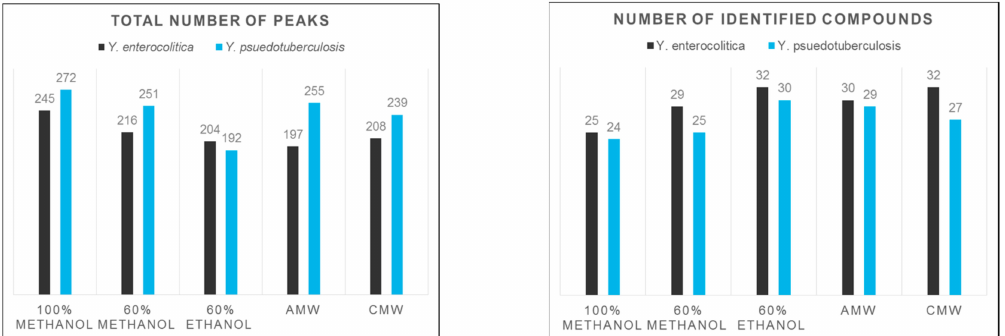
Figure 4. Comparison of the total number of peaks ( left ) and number of identified compounds ( right ) for each representative spectrum corresponding to the solvent treatment.